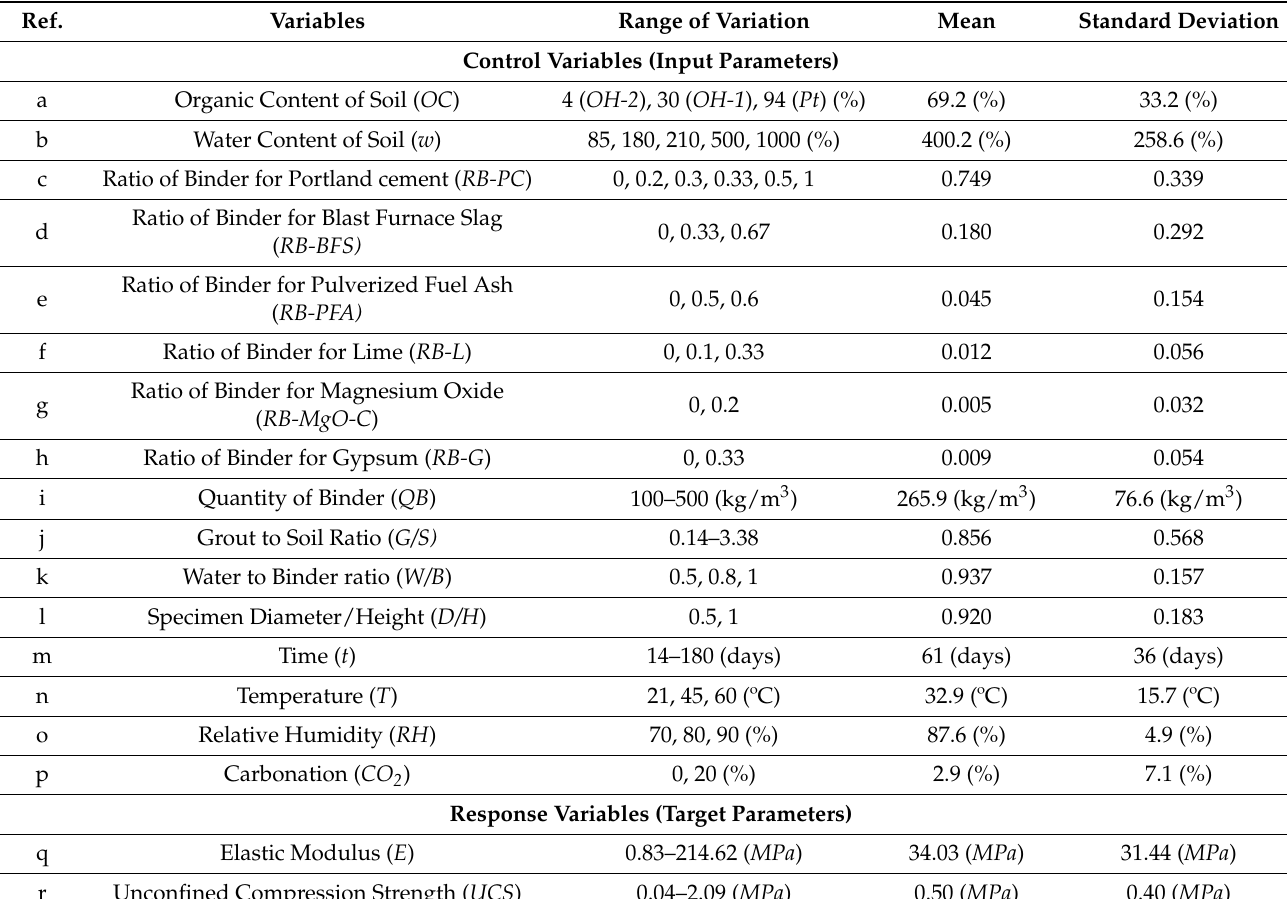
Table 3. Control variables and ranges of